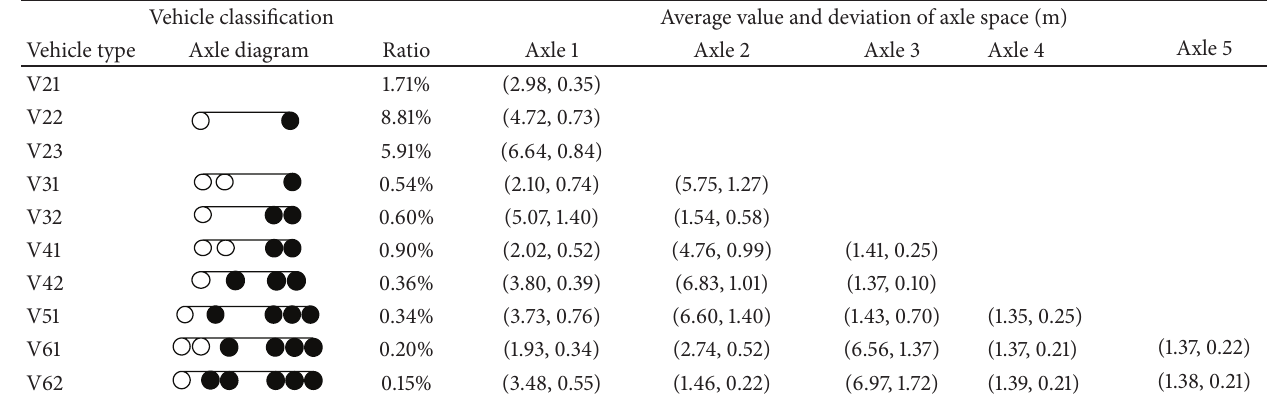
Table 3: Vehicle classification and axle space